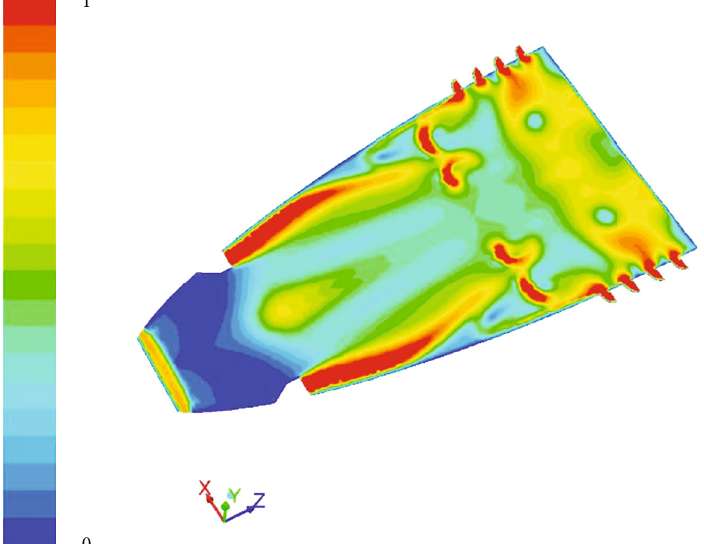
Figure 5: Velocity distribution in upper area of nacelle in the horizontal plain.